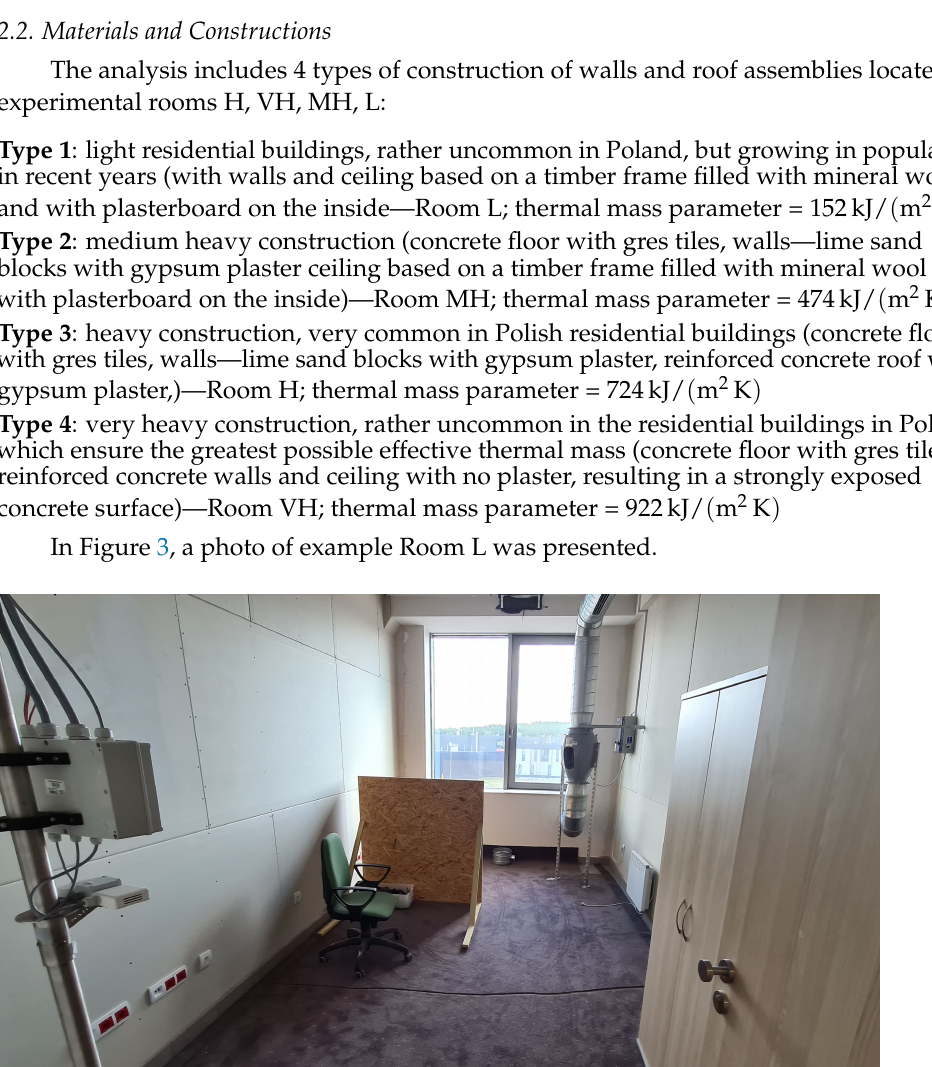
Figure 2. Plan of the top floor of the building with the locations of experimental rooms and thermo- hygrometers (indicated as red squares).